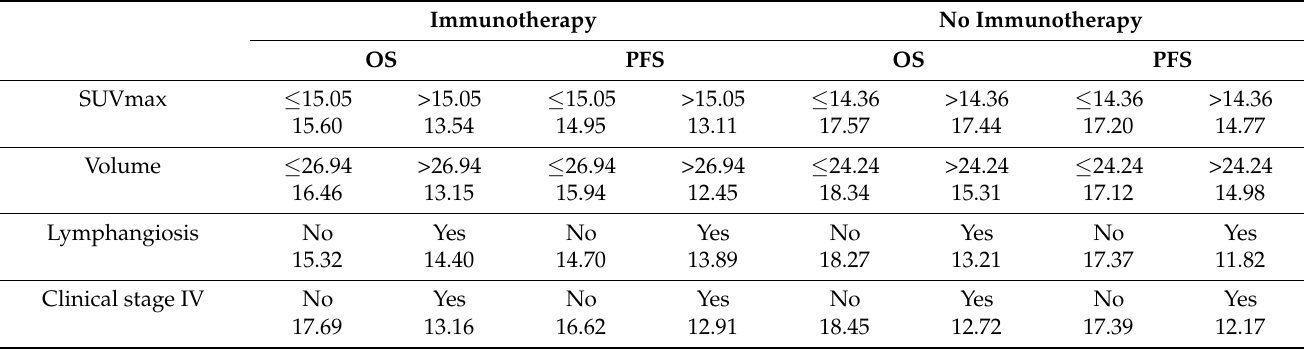
Table 5. The table summarizes the impact of the predictive parameters described above on the long-term outcome (overall survival (OS) in months and progression-free survival (PFS) in months), depending on whether the considered predictive parameter was lower or higher than the predefined cut-off value for the continuous predictive parameters or whether the considered predictive parameter was present or not for the categorical predictive parameter. For the continuous predictors, such as SUVmax and volume cut-off values were defined for both treatment regimens, e.g., treated with and without immunotherapy. The cut-off values were defined as the values for which the two considered reference groups ( ≤ vs. >cut-off value) differed the most in their probability of survival over time. For the categorical predictors, such as lymphangiosis and clinical stage IV, the presence of the considered predictor was documented as yes, and the absence as